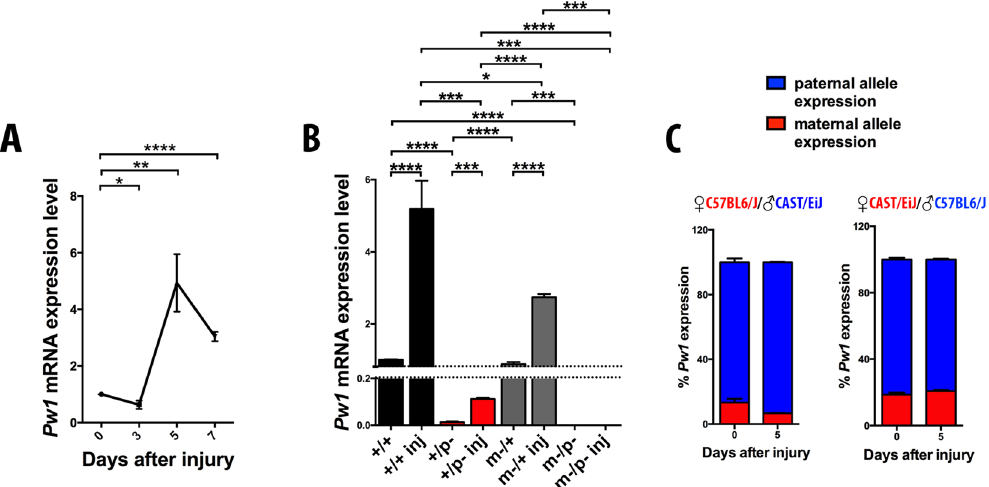
Figure 2. Paternal and maternal Pw1 alleles are transcribed in skeletal muscle. ( A) Expression levels of Pw1 wildtype allele normalized to Hprt1 gene expression from real time PCR at three, five, and seven days after CTX injury in adult Pw1 + / + TA muscle (n = 3 for each genotype). Pw1 has a peak of expression five days after muscle injury. (B) Expression levels of Pw1 wildtype allele from real time PCR normalized to Hprt1 gene expression in uninjured and five days after injury adult Pw1 + / + , Pw1 + /p − , Pw1 m − / + , and Pw1 m − /p − TA (n = 3 for each genotype). Maternal Pw1 transcript is detected in injured Pw1 + /p − muscles. (C) Pw1 allele specific expression in adult TA muscle before and five days after CTX injury from reciprocal hybrid offspring of C57BL6/J and CAST/EiJ mice (n = 3 for each genotype). Bi-allelic Pw1 expression was observed in adult injured and uninjured muscle tissue. Values are expressed as mean ± s.e.m. In all the graphs statistical analyses were performed using Student’s t-test * P < 0.05, ** P < 0.01 and *** P < 0.001. In all the graphs Pw1 + / + ( + / + ), Pw1 + /p − ( + /p − ), Pw1 m − / + (m − / + ), and Pw1 m − /p − (m − /p −